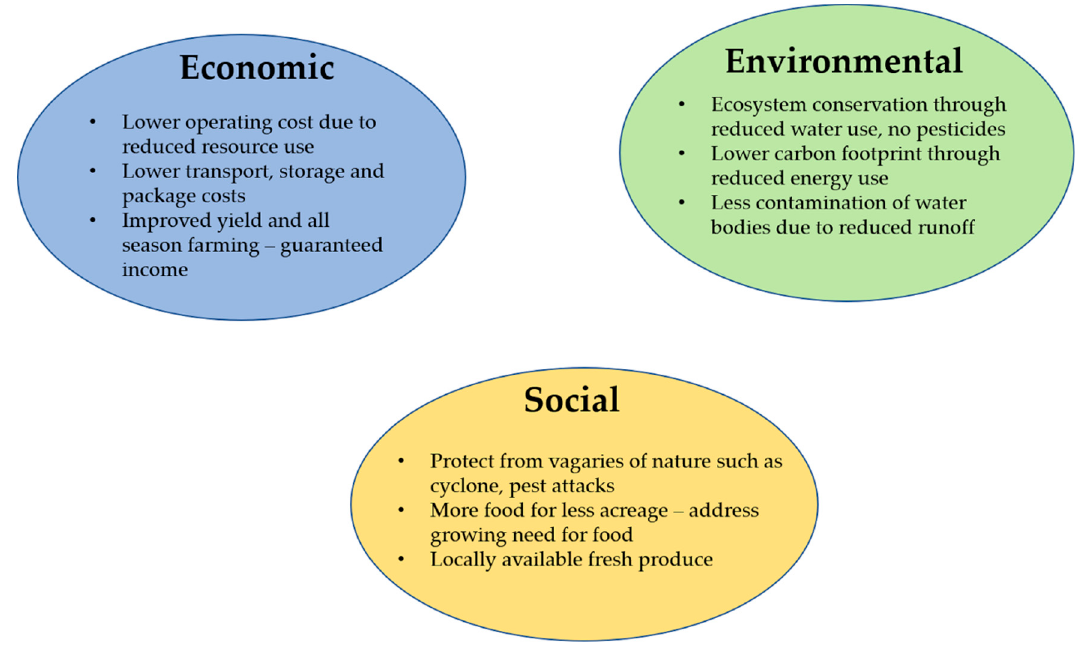
Figure 1. Potential economic, environmental and social benefits of protected cropping in warm climates. 92